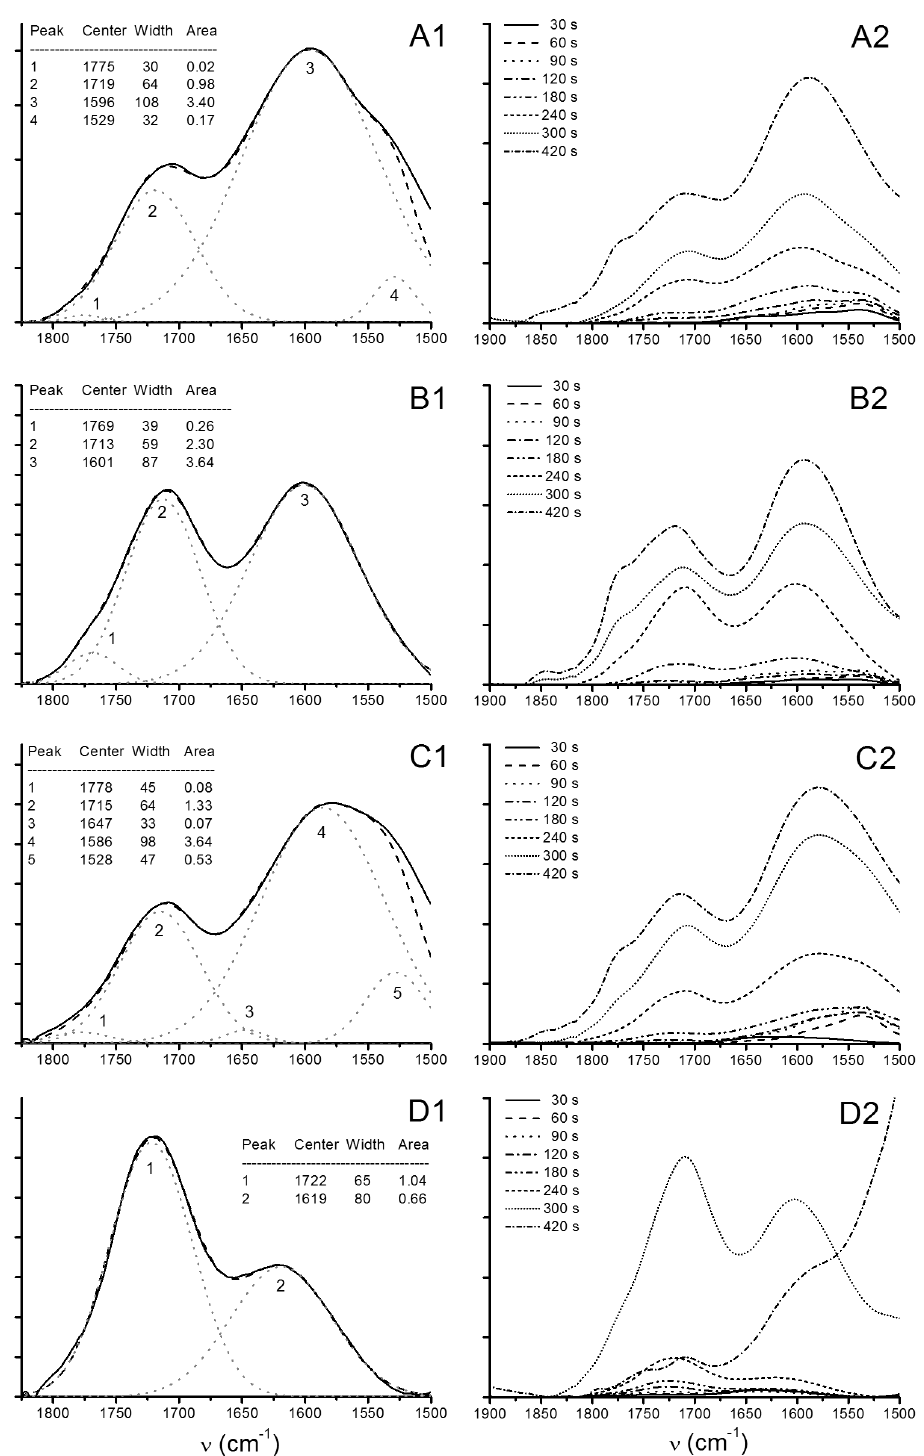
Figure 9. ATR-FTIR spectra from thermal decomposition kinetics of LDH containing pulps at 613 K ( 340 ◦ C) (( A ) lss ; ( B ) hss ; ( C ) Uhyd ) and ( D ) fully bleached Kraft pulp reference. Deconvoluted FTIR spectra after 240 s in range of 1500 – 1850 cm − 1 are presented in figures ( A 1– D 1), and signal evolution within 420 s in figures ( A 2– D